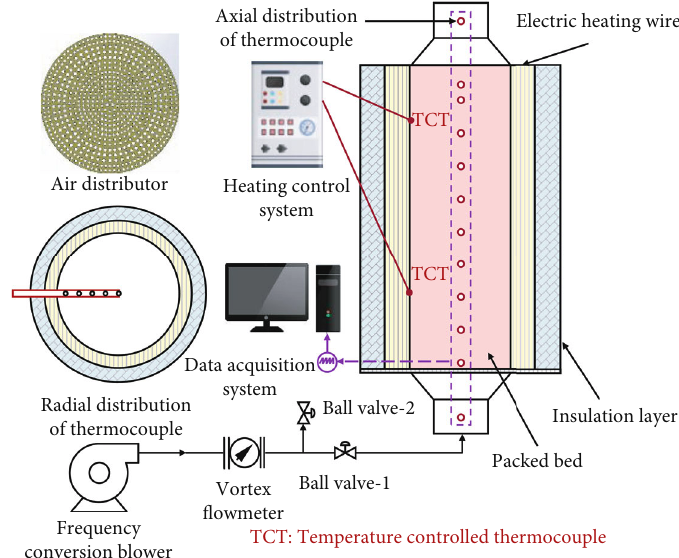
Figure 2: Schematic diagram of the gas-solid heat transfer test-bed for the Table 2: Experimental conditions and characteristic parameters for 7 kinds of particle sizes. Particle size d (mm)